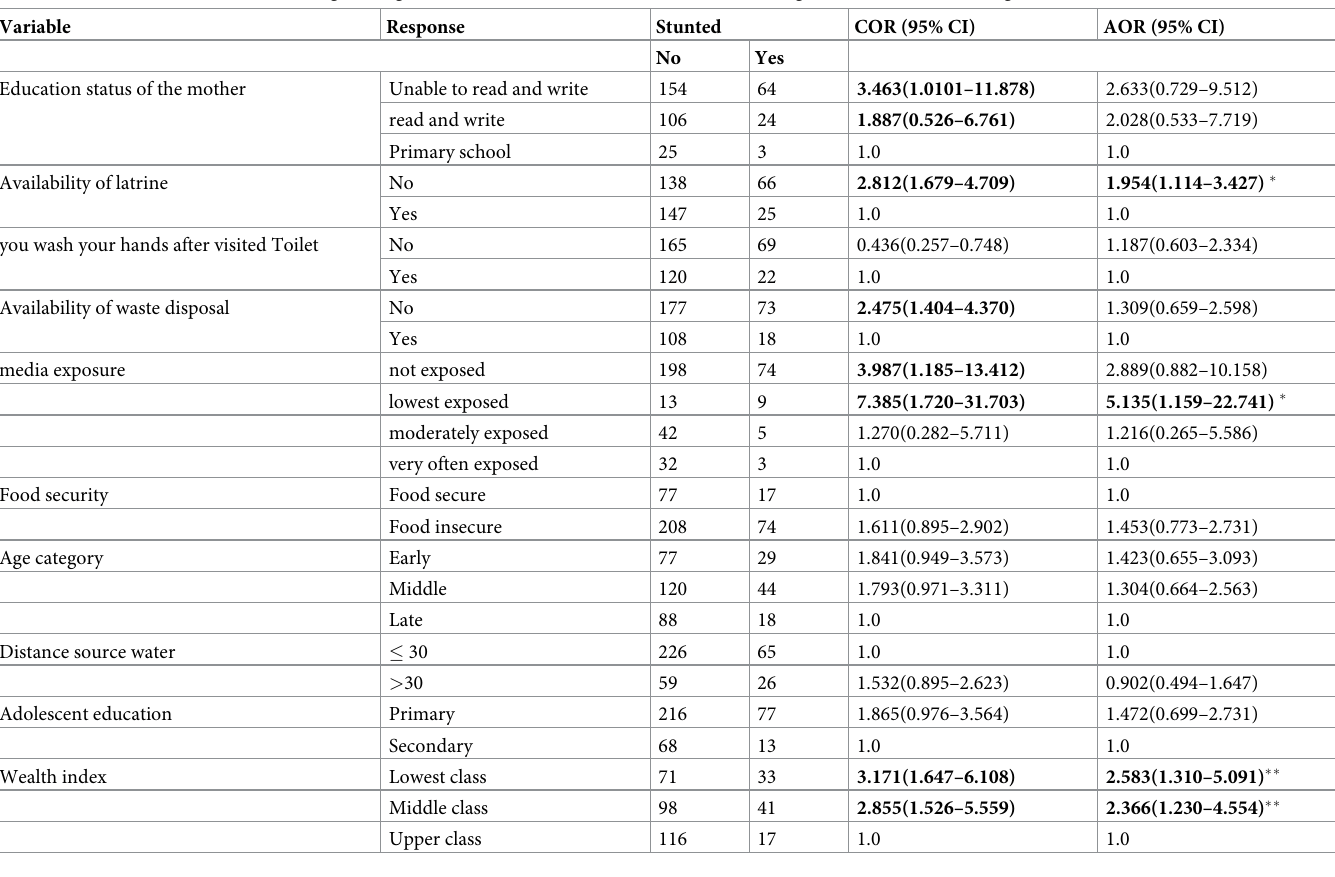
Table 3. Bivariable and multivariable logistic regression of factors associated with stunted among rural school adolescent girls, 2020 (n = 376). Variable